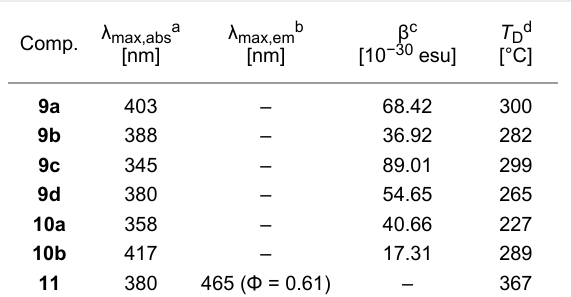
tions (Figure 7): D- π -IM-( π -A) 2 ( 16 ), A- π -IM-( π -D) 2 ( 17 ), A- π - IM-( π -A) 2 ( 18 ), and D- π -IM-( π -D) 2 ( 19 ).